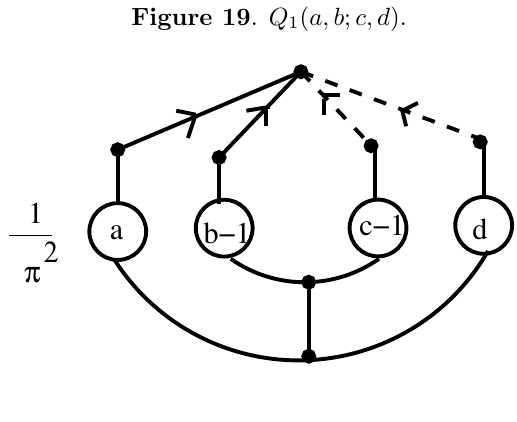
Figure 19 . Q 1 ( a; b ; c; d ).